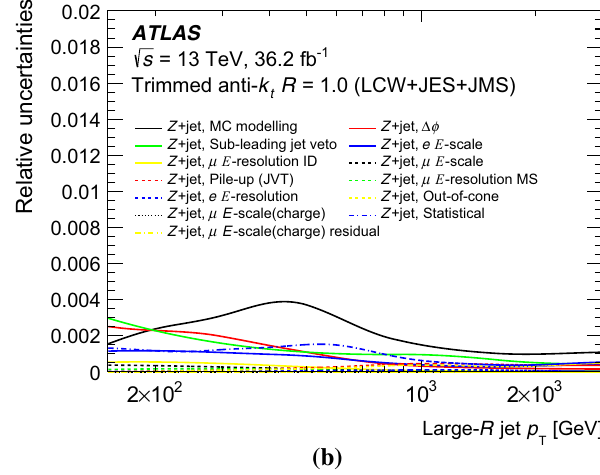
Fig. 28 Breakdown of the combined uncertainty in the large- R jet p T response as a function of the jet transverse momentum p T , for the a γ +jetand b Z +jetanalyses.Contributionsareshownforeachofthenui- sance parameters of the γ +jet and Z +jet balance methods. The vertical axis reflects the uncertainty introduced by a given nuisance parameter